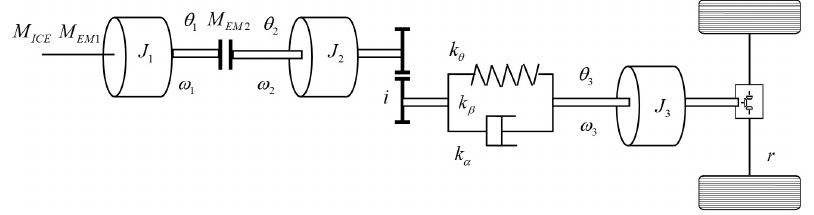
Figure 2. Modelling HEV’s powertrain.